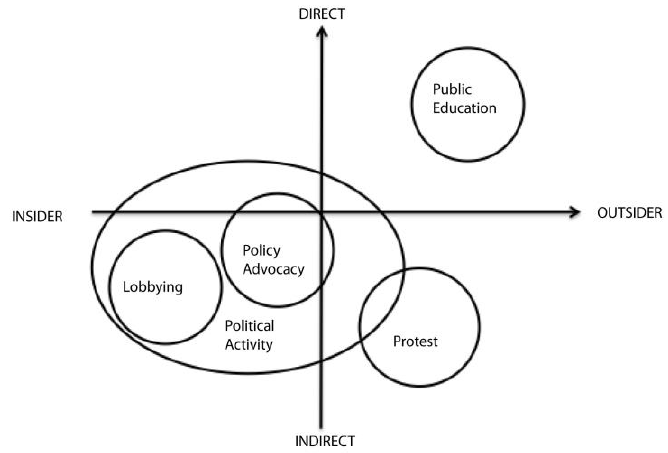
Figure 1. Conceptual relationship between lobbying, policy advocacy, protest, public education and political activity. Source : Pekkanen and Smith [2].